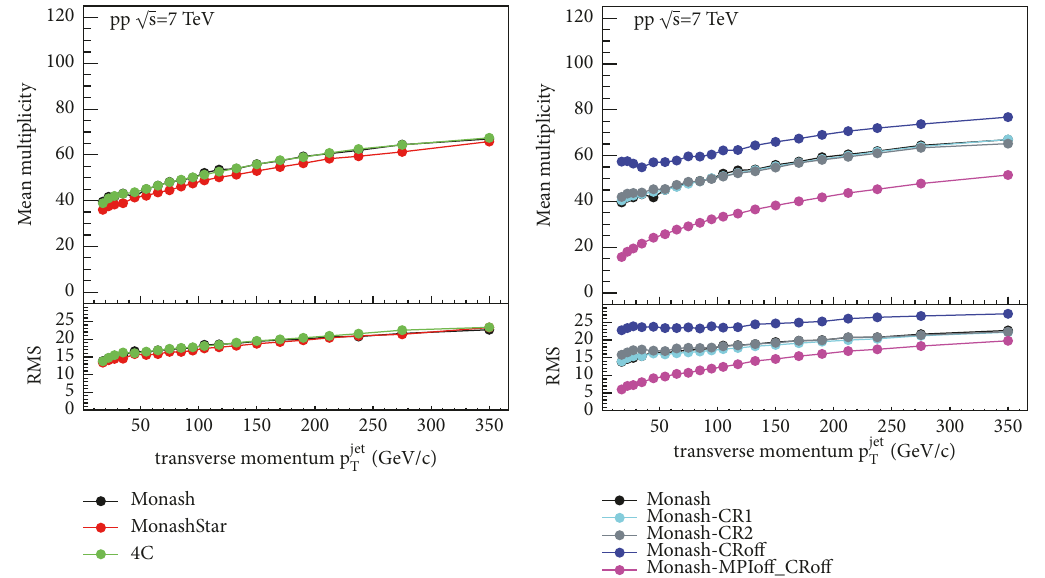
Figure 3: Mean and RMS values of the event multiplicity distributions for jets depending on 𝑝 jet settings (right) . The uncertainties of the mean and RMS values are smaller than the symbol size.